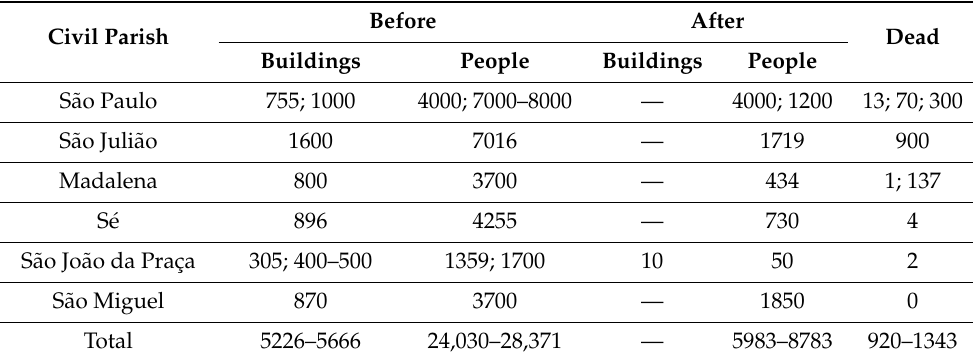
Table 1. Census data (before and after the earthquake) and the number of dead. Data compiled from [3]. The population data considers people older than seven years of age. The census data have several discrepancies, and di ff erent records are separated by “;”. Civil